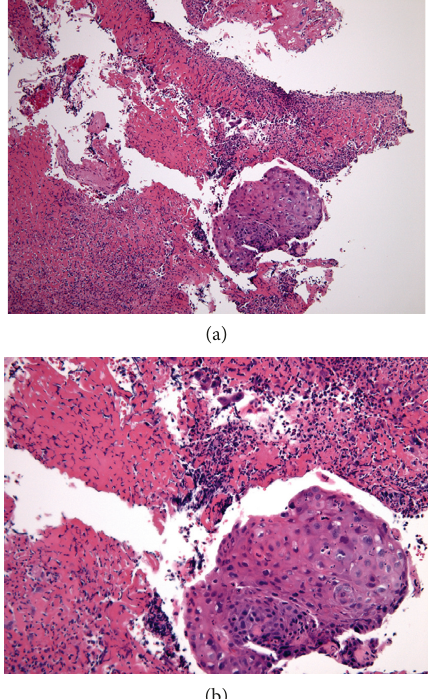
Figure 3: Histopathological findings for hypopharyngeal tumor biopsy. Features observed include increased nuclear chromatin, disparity between large and small nuclei, and signs of mitosis. These findings are indicative of squamous cell